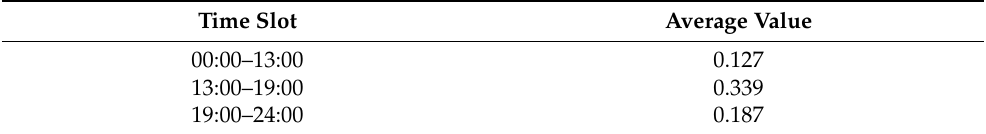
Table 2. Poisson distribution with associated average values. Time